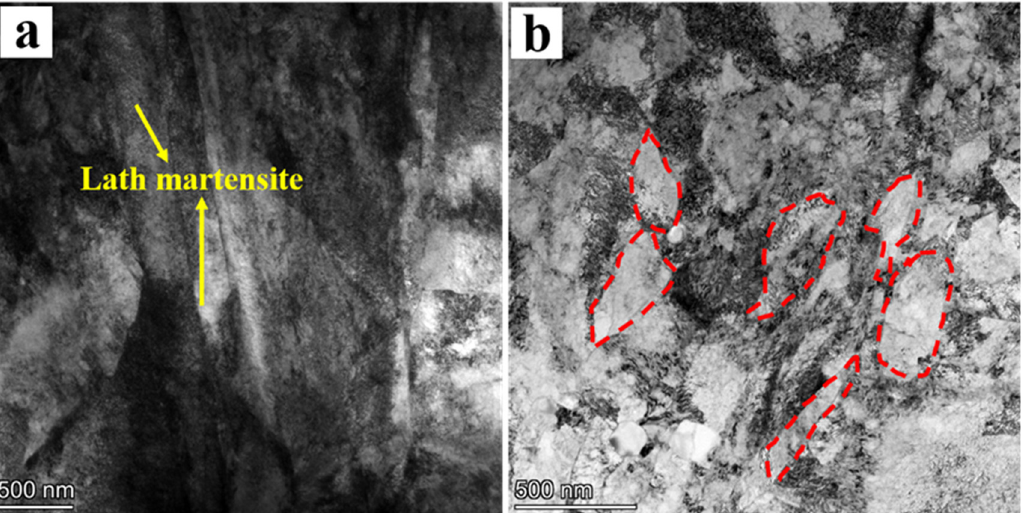
Figure 15. ( a ) TEM image of the carburized layer in the C state; ( b ) TEM image of the modified layer in the C + 200P state.